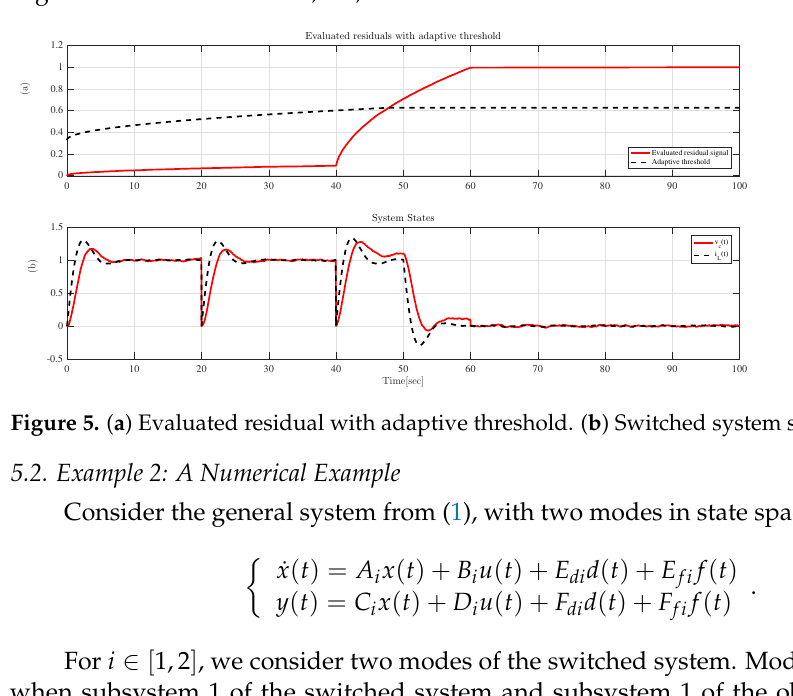
Figure 4. ( a ) Residual signals without fault. ( b ) Residual signals with fault. Figure 5 shows the evaluated residual along with adaptive threshold and state tra- jectory of the system, which maintains its stability, even when the fault is applied. The adaptive threshold is computed by using (20), in which the constant threshold is calculated offline as j thd = 0.0563 for both of the modes. In addition, the adaptive threshold is com- puted at τ = 47.694 as j thadpt = 0.6244. Thus, fault is detected when the evaluated residual is greater than its threshold, i.e., r = 0.6246 > 0.6244.